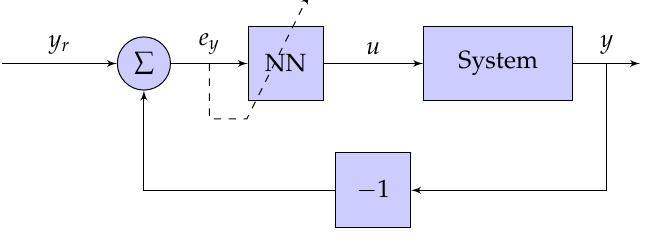
Figure 6. A block scheme of the control